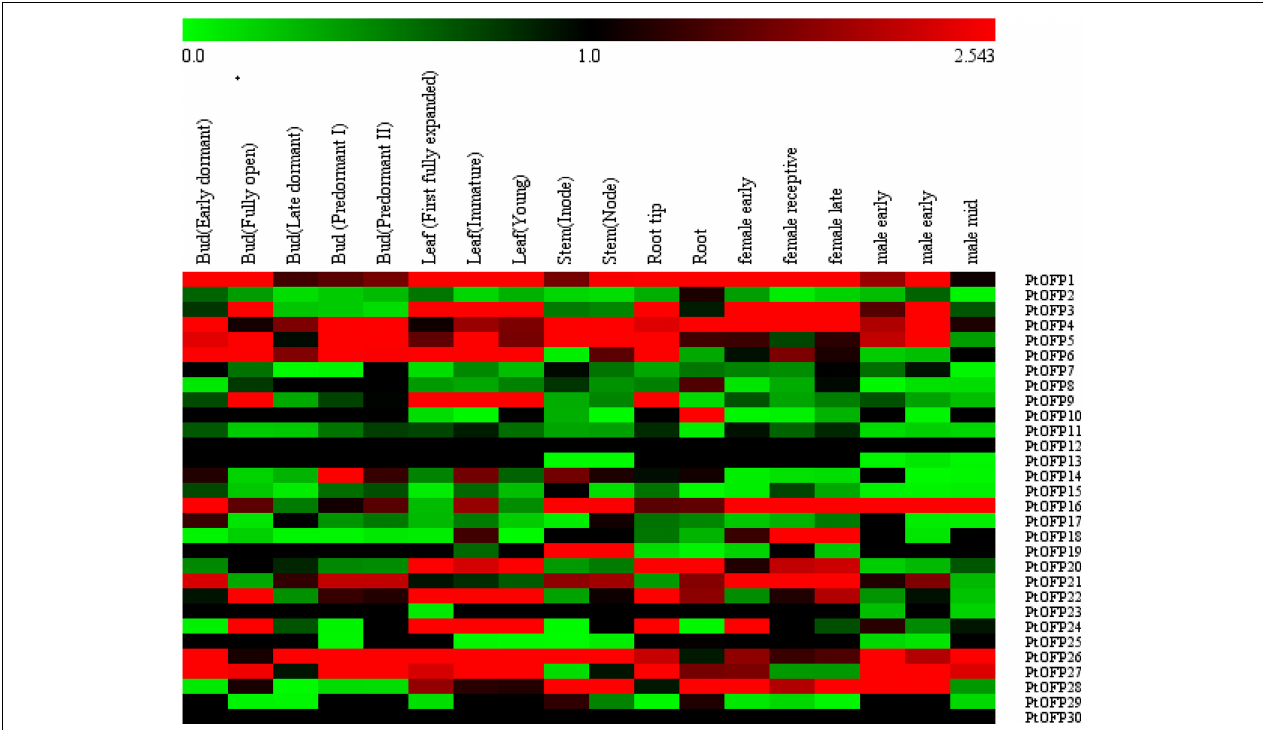
FIGURE 3 | Heatmap of the expression levels of PtOFP family genes during different developmental stages in different tissues and organs. The tissue types are shown on the top, and the genes are shown on the right. Scale bars at the top represent log 2 -transformed FPKM values. Red indicates high expression level and green indicates low expression